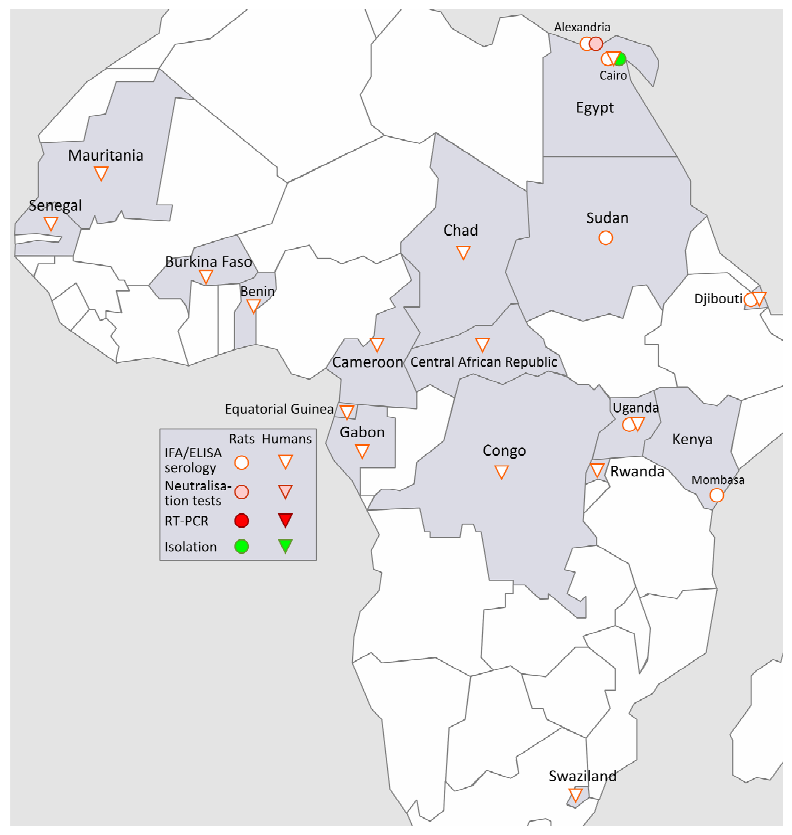
Figure 4. The map does not aspire to completeness and refers only to data given in the text. The first and only SEOV isolations in Africa to date were obtained from wharf rats in Cairo, Egypt, in 1983–1984 [39]. Despite strong evidence since the 1980s for the presence of a SEOV-like agent in humans and / or wild rats in 17 di ff erent African countries, no full clinical and serological description of an autochthonous SEOV-HFRS is available so far (see